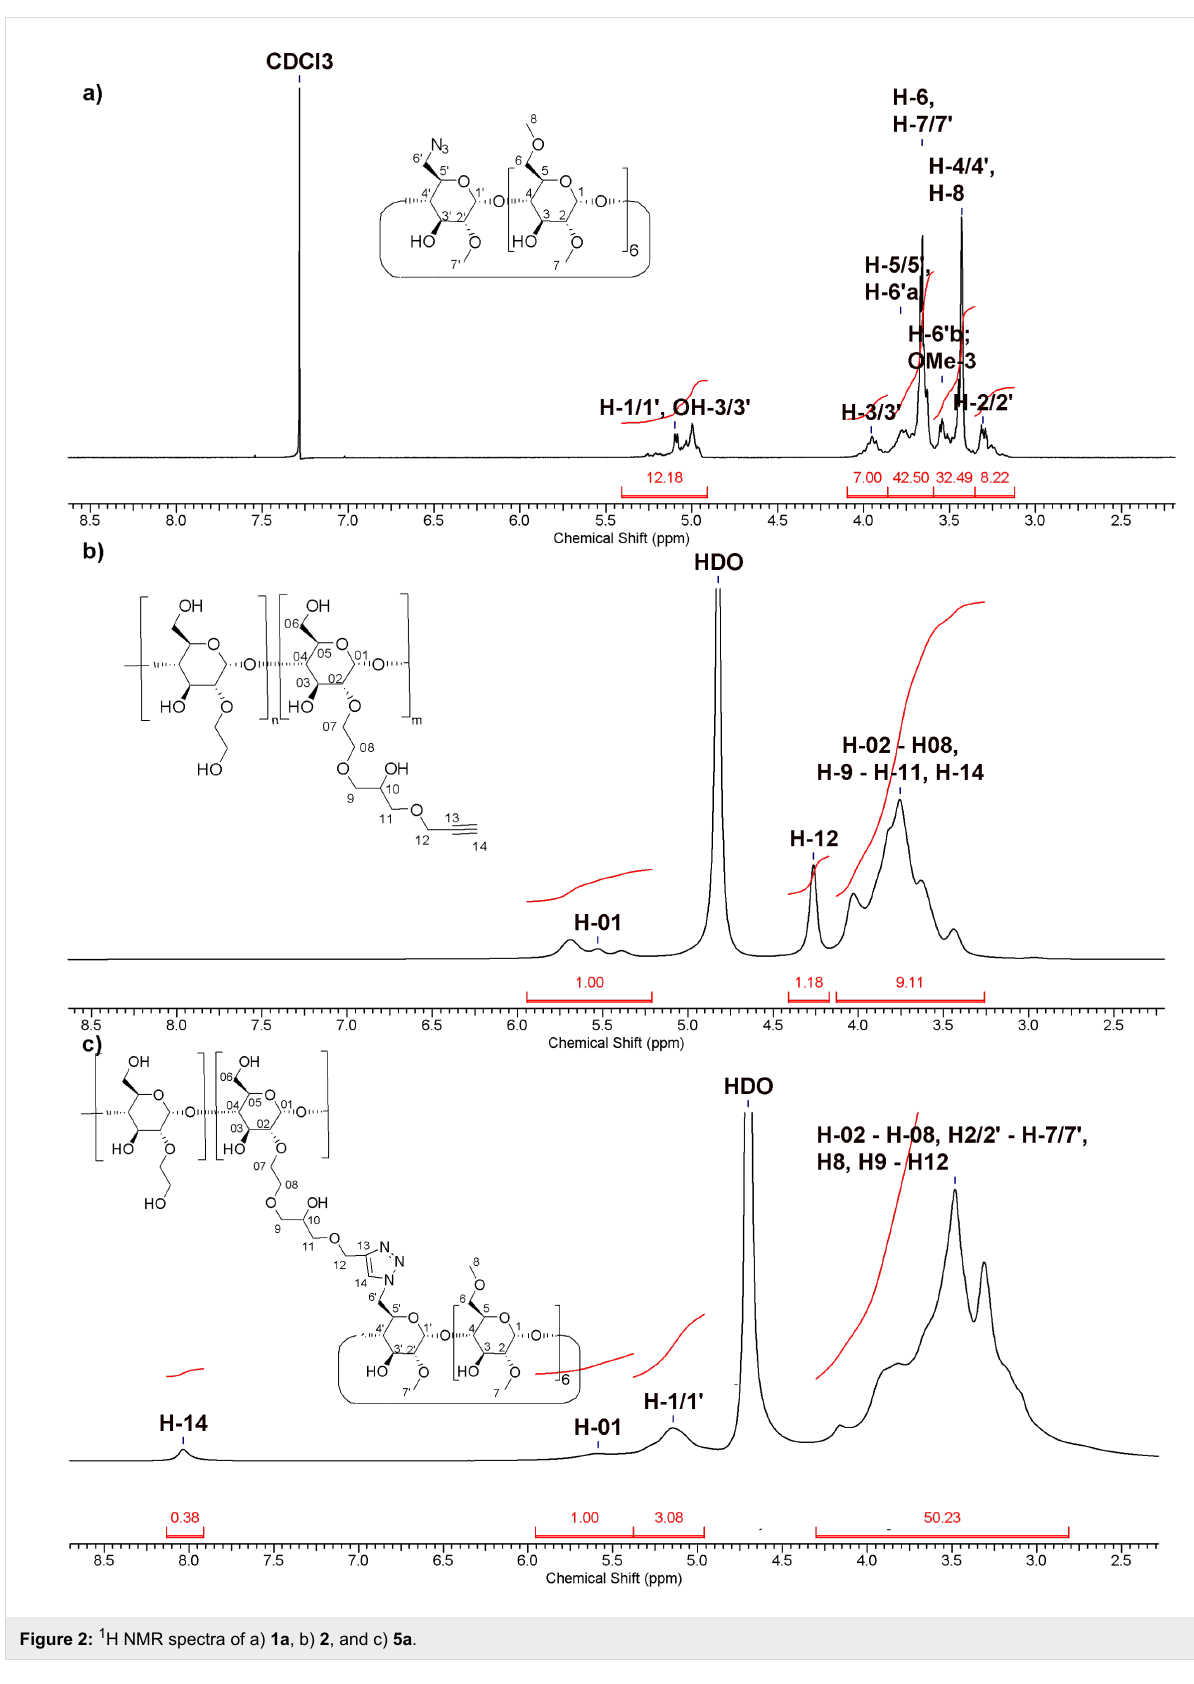
Figure 2: 1 H NMR spectra of a) 1a , b) 2 , and c) 5a